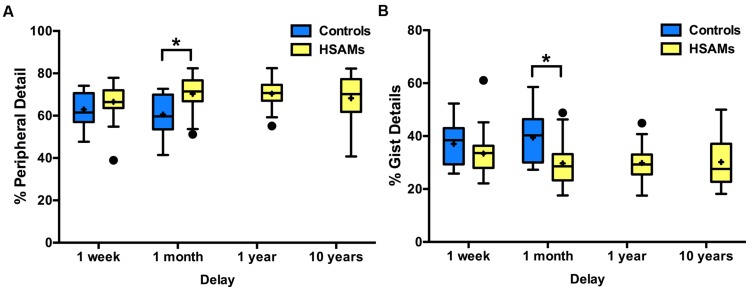
Percentage internal peripheral and internal gist detail recalled over time. Box and whisker plots (Tukey style) represent (A) percent peripheral details and (B) percent gist details recollected at each delay (HSAM n = 27, yellow bars; control n = 10, blue bars). HSAM participants recall significantly more gist and peripheral details at the 1-month time point. ∗p < 0.001. Graph B is (and must be) a mirror image of A. Control data is only represented for the 1-week and 1-month delays as there was insufficient data for 1-year and 10-year delays. “+” indicates average value.